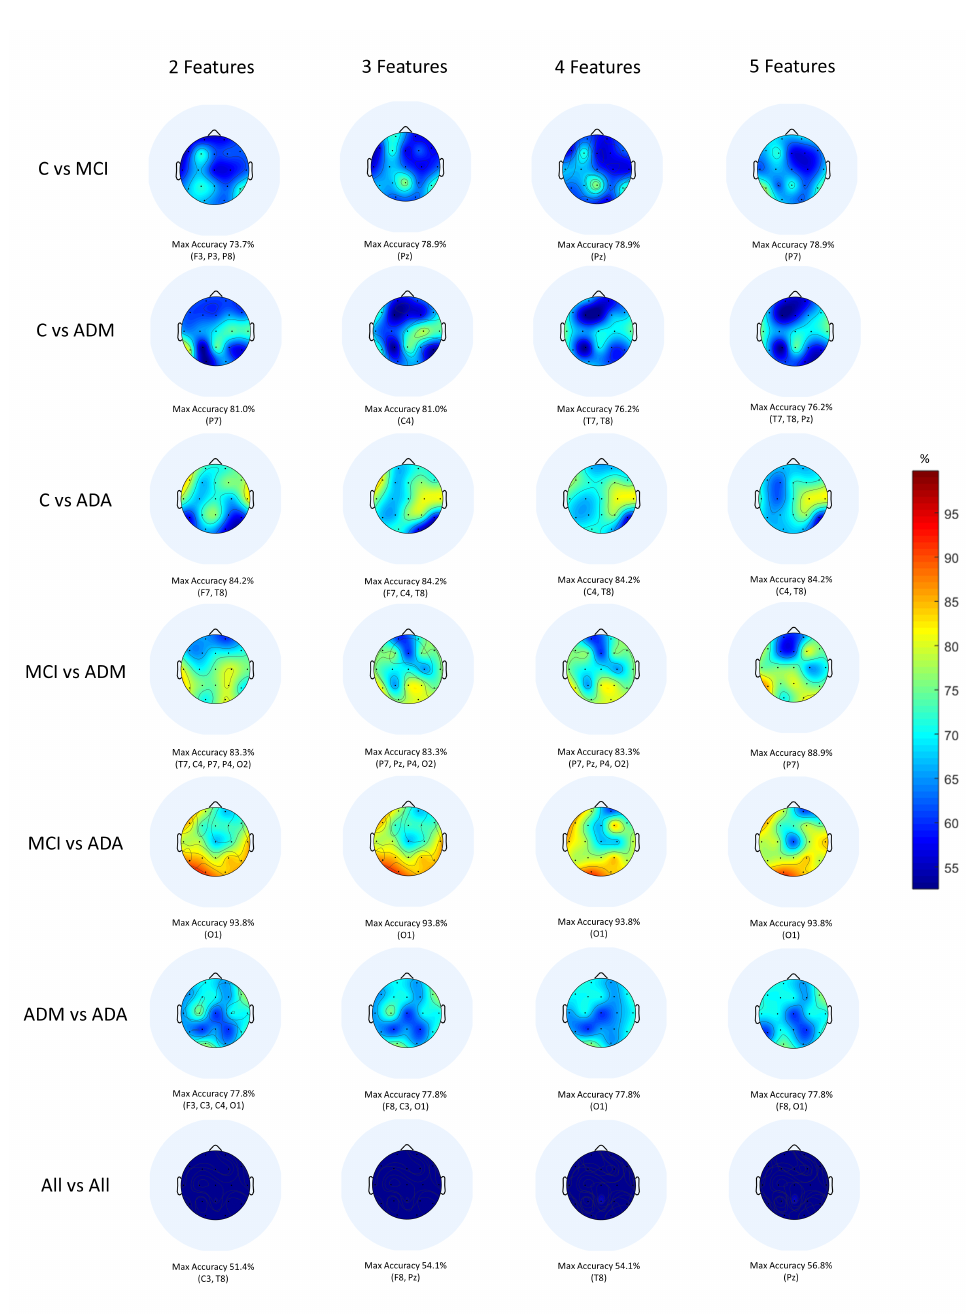
Figure 5. Topographic maps provided by a Classic ML